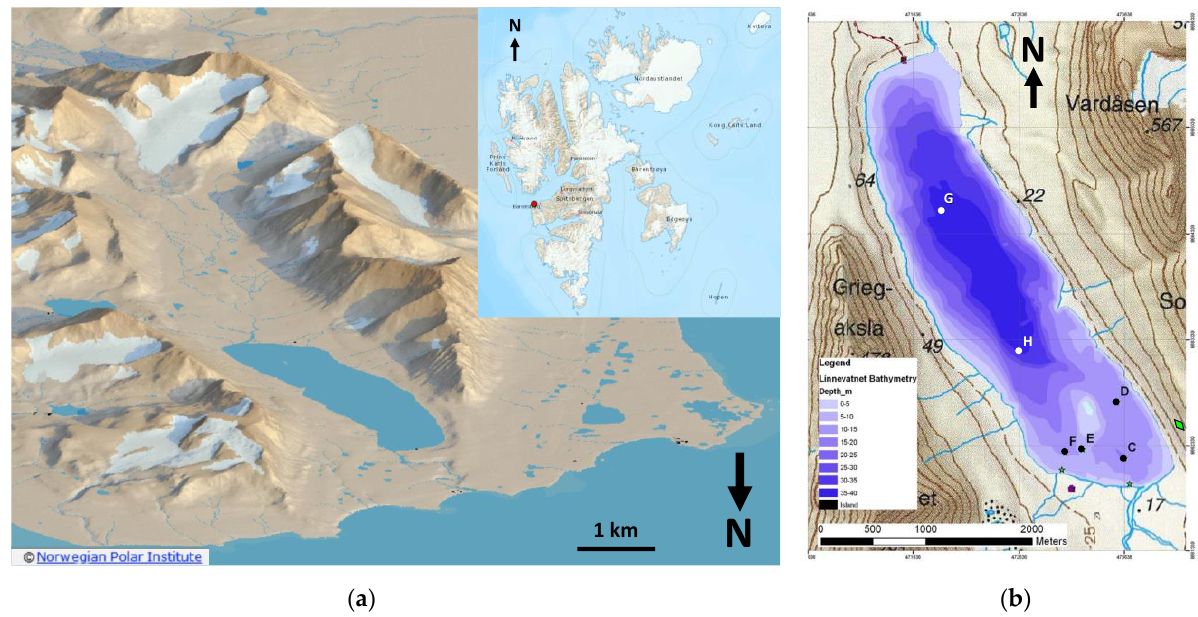
Figure 1. ( a ) Three-dimensional digital elevation model (DEM) of Linnévatnet and the surrounding Linnédalen valley, along with inset map of Svalbard showing the location of Linnévatnet on the western coast of Spitsbergen (red dot). Images from TopoSvalbard, courtesy of the Norwegian Polar Institute. ( b ) Bathymetric map of Linnévatnet, showing the locations of water temperature profiles (indicated by white and black dots and labeled with capital letters). Water temperature from mooring G, located in the deepest part of the lake, was used in this analysis. The location of the automated cameras is shown in the green diamond near the southeast corner of the lake.